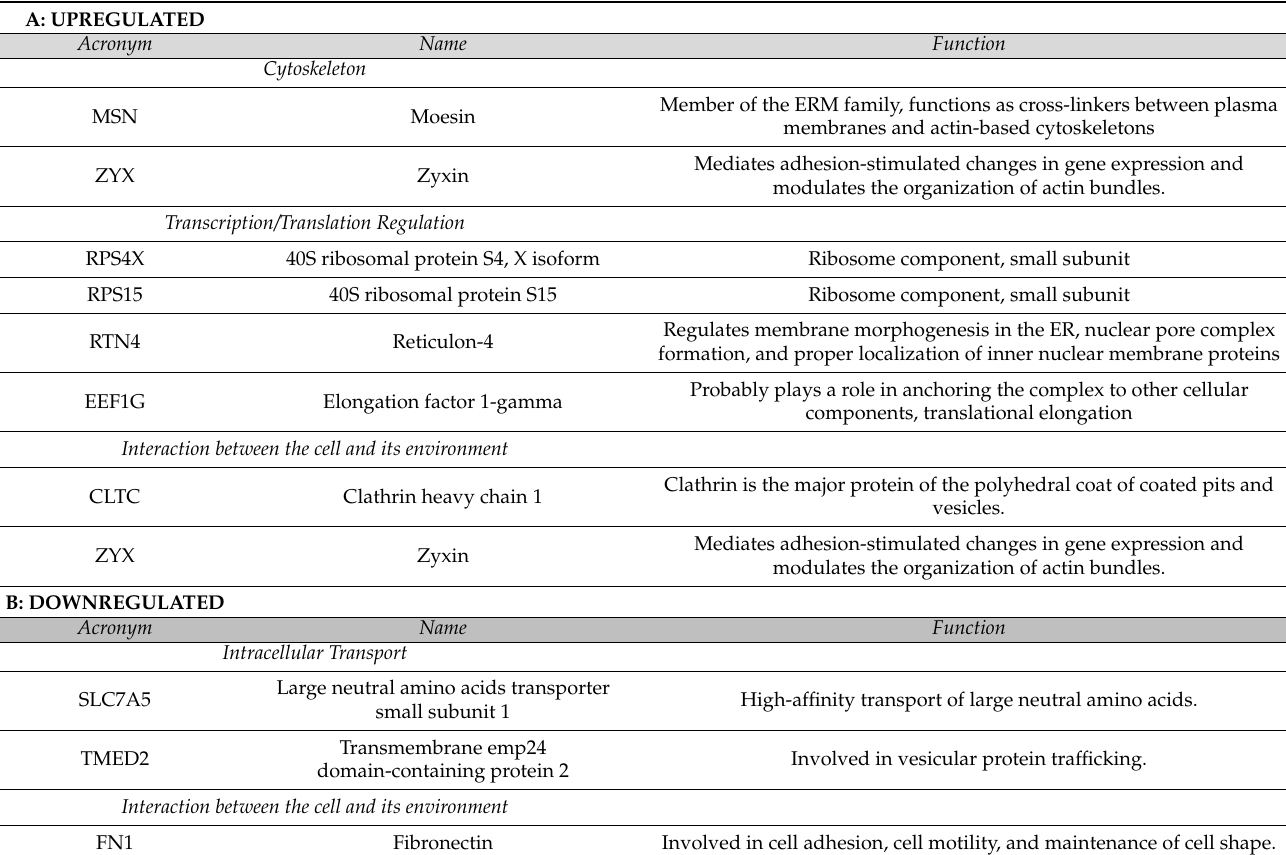
Table 4. Proteins which expression was altered between H6 and H12.